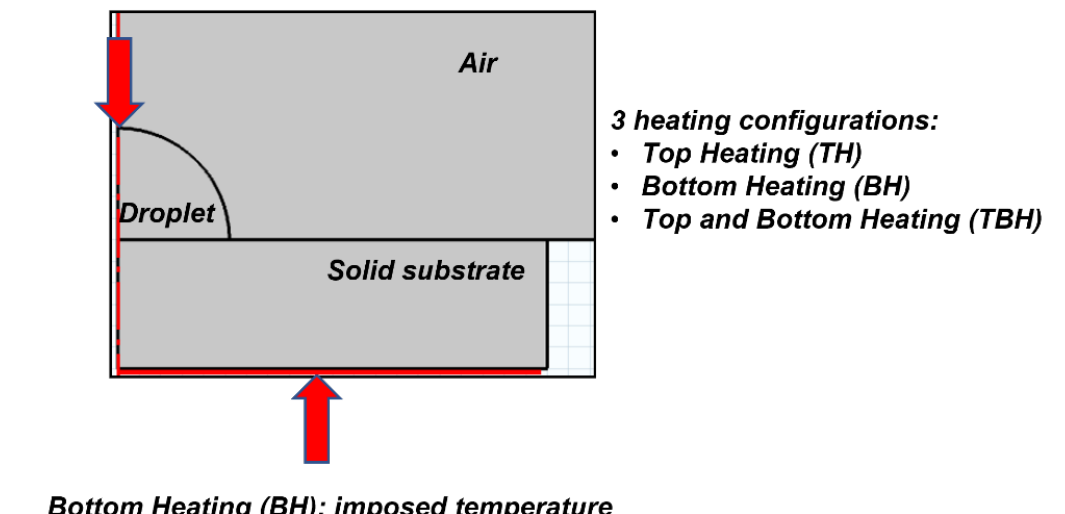
Figure 1. Heating configurations (The red arrows designate the heating direction (top or bottom)).